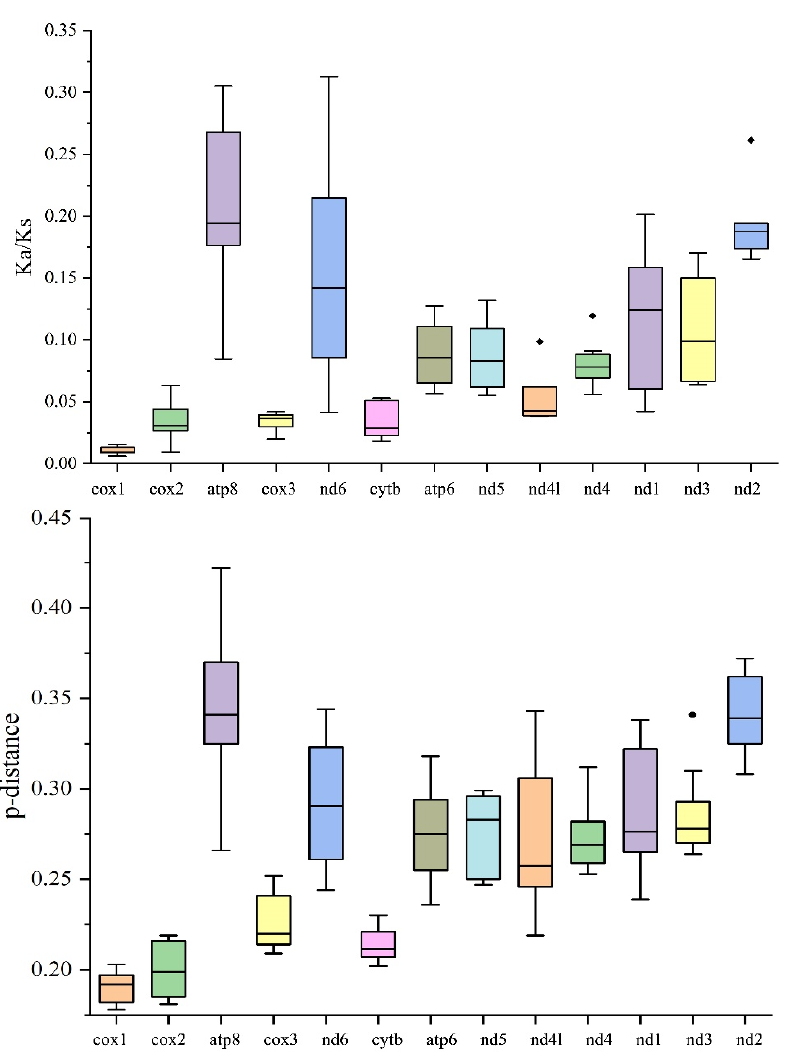
Figure 1. Pairwise Ka/Ks and p-distance of 13 PCGs between five mitogenomes. The band within the box represents the median; upper and lower hinges correspond to the 25th and 75th percentiles; upper and lower whiskers correspond to 1.5 IQR from the upper and lower hinges; dots correspond to outliers.